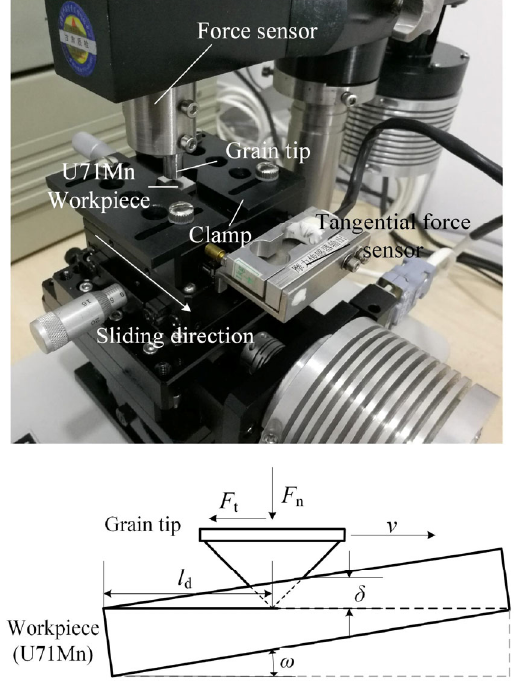
Fig. 7 CAS WS-2005 scratch apparatus and experiment settings. Mechanical properties of